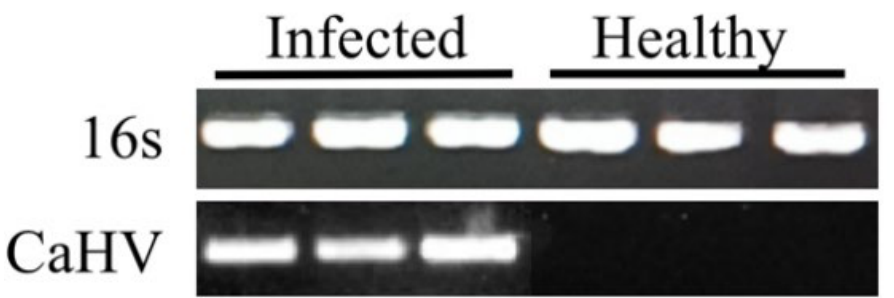
Figure 6. DNA extraction of diseased fish using the skin mucus swabbing and disc method. DNA was extracted from three CaHV-infected and three healthy crucian carp. The 16s rRNA gene and CaHV DNA polymerase gene were amplified, respectively.